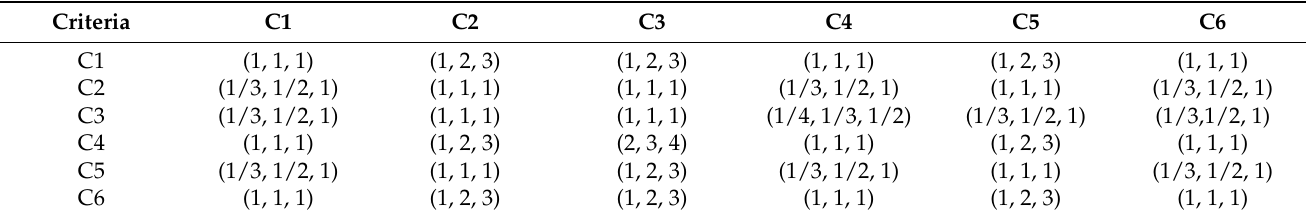
Table 2. Individual fuzzy judgment matrix of expert 1.